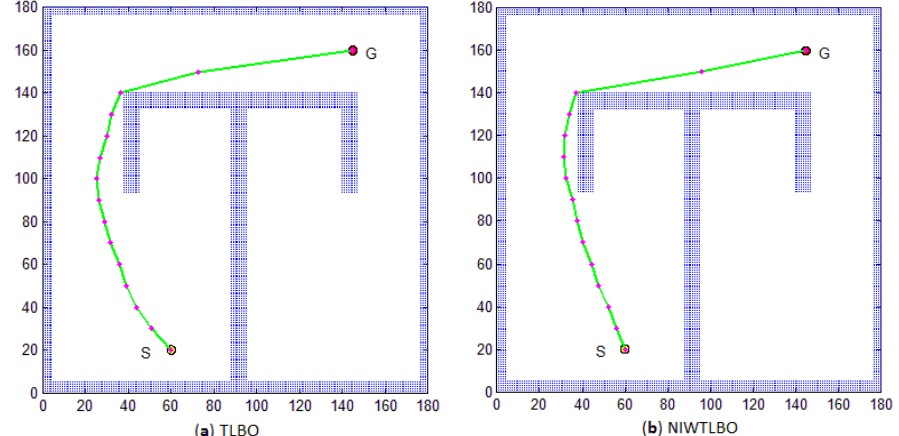
Figure 5. Path planning in the scenario of T_30. D = 13. ( a ) The result of the TLBO; ( b ) The result of the NIWTLBO.